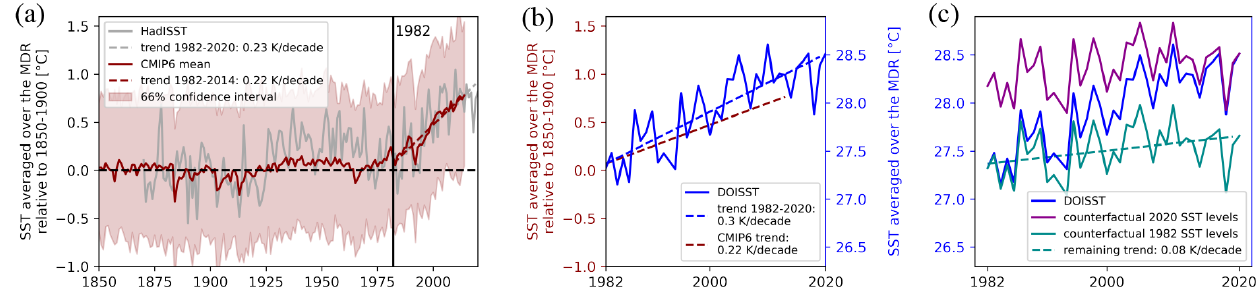
Figure 5. Sea surface temperatures averaged over August–October and the MDR. (a) Ensemble mean of historical CMIP6 simulations (red) relative to 1850–1900 and HadISST observations (gray) relative to 1870–1900. The 66% range of the CMIP6 ensemble is represented by the red shading. Linear trends for CMIP6 (HadISST) over the period 1982–2014 (1982–2020) are indicated by dashed lines. (b) DOISST observations for the period 1982–2020 in blue and respective to the right y axis. Besides the linear trend in DOISST, the linear trend of CMIP6 is indicated by a red dashed line using the left y axis. (c) Counterfactual SST scenarios based DOISST observations from which the CMIP6 trend is removed. This detrended SST time series is shifted to the value of the CMIP6 trend in the year 1982 (cyan) and the year 2020 (purple). The remaining linear trend in these counterfactual scenarios is indicated by a dashed